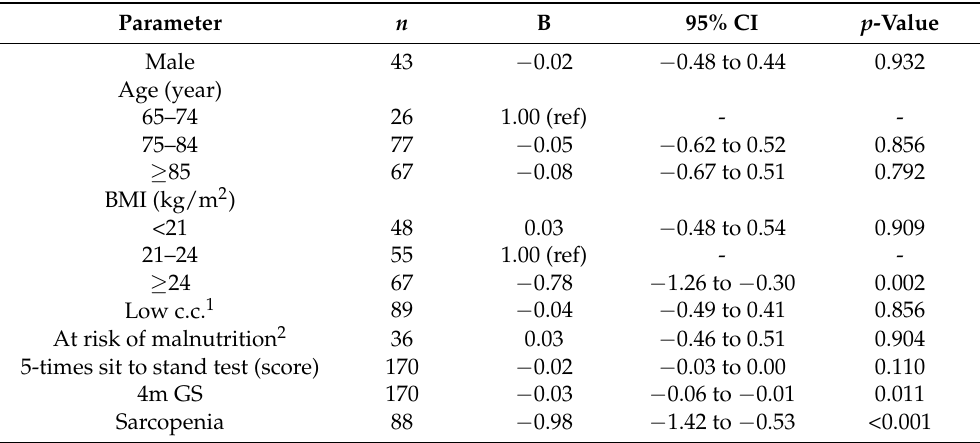
Table 4. Analysis of the correlation between the parameters of sarcopenia and standing balance among older adults at daycare centers ( n =